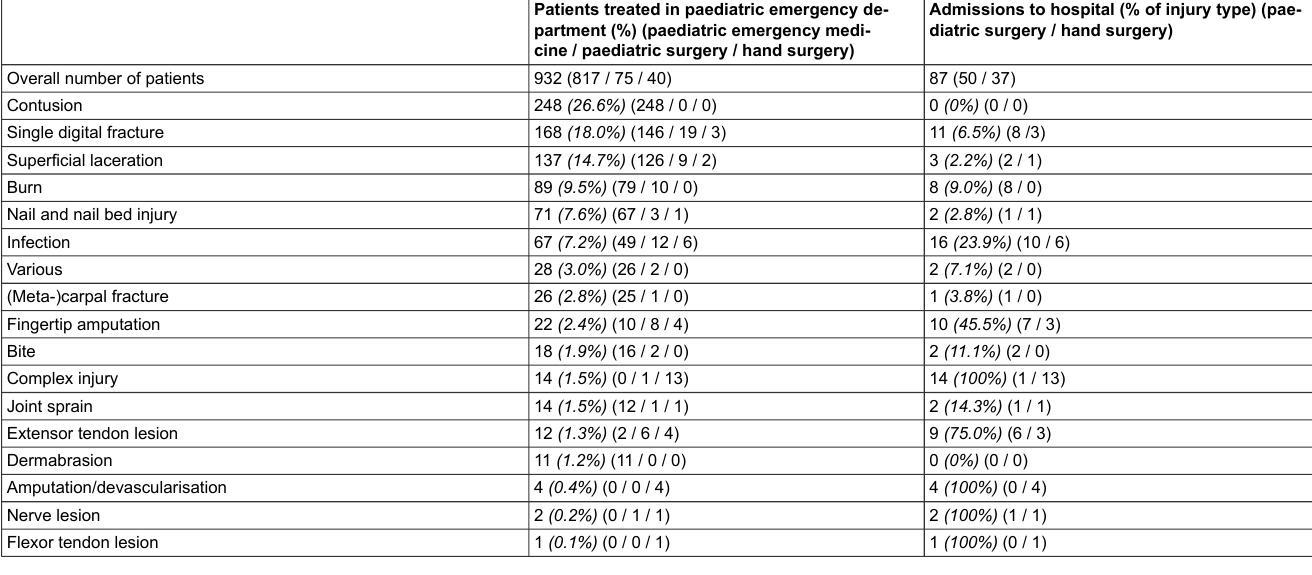
Figure 2: Frequency of fingers affected in paediatric hand and finger